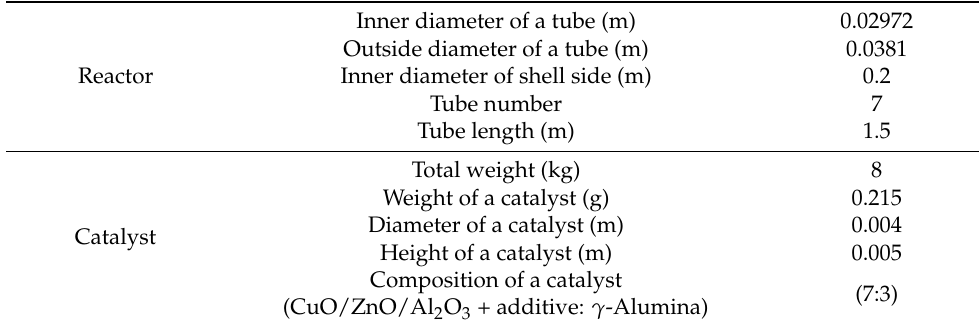
Table 1. Properties of the catalyst and information on the pilot-scale reactor in a